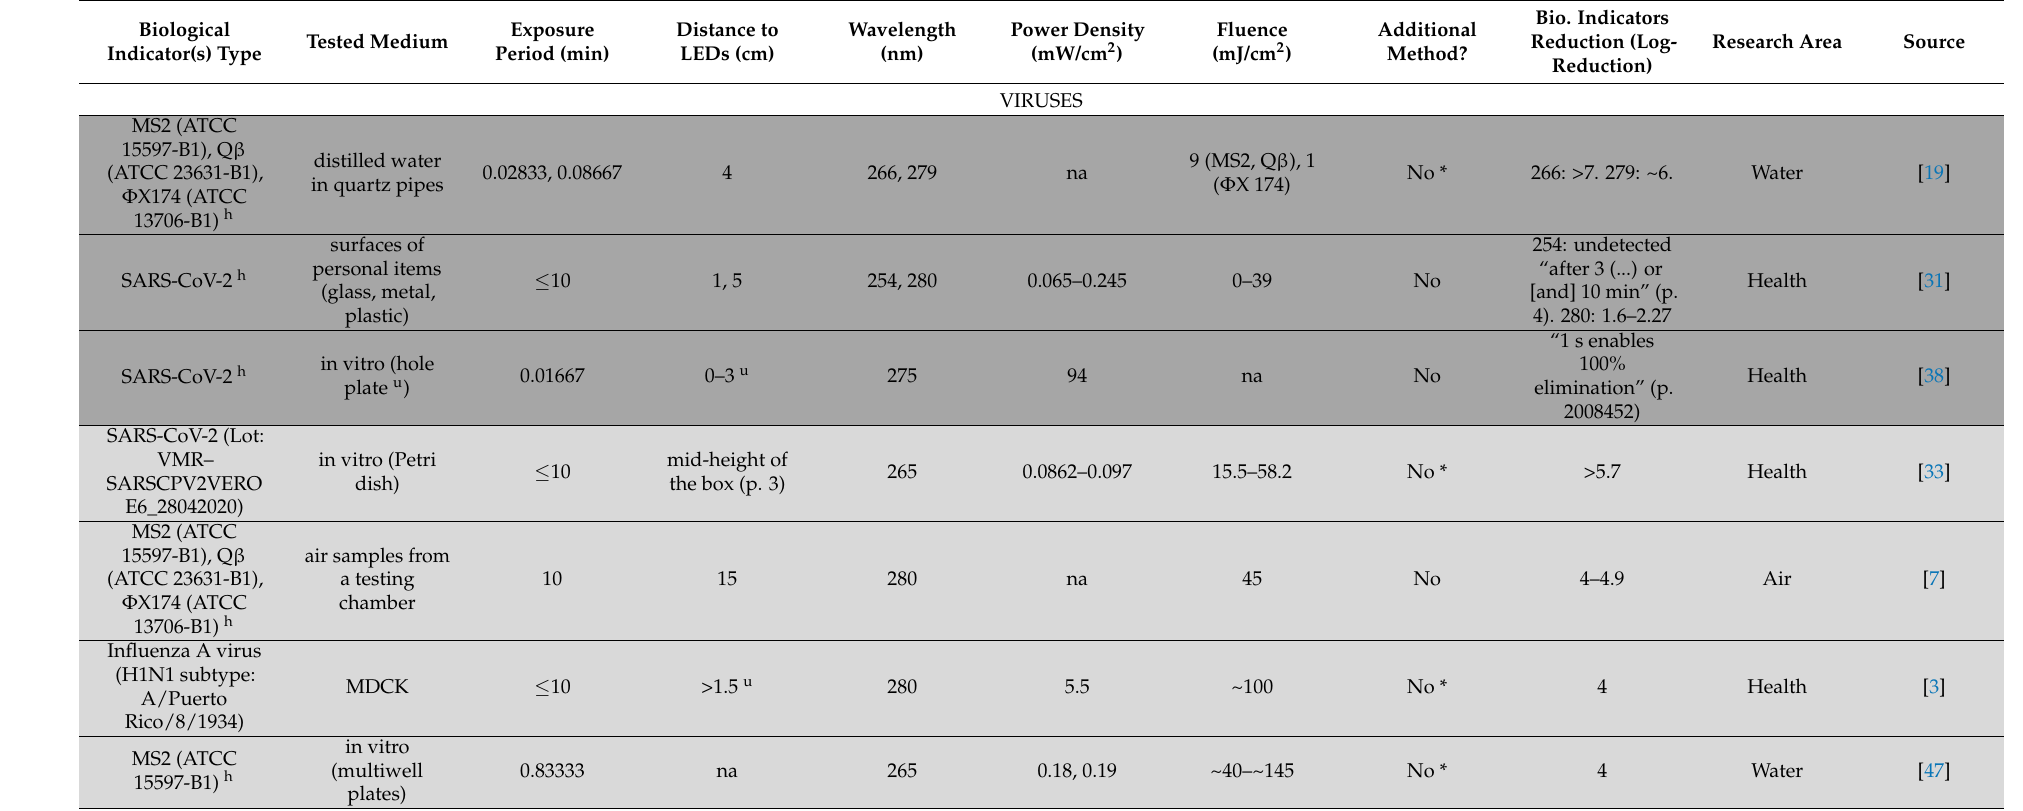
Table A1. SLR results